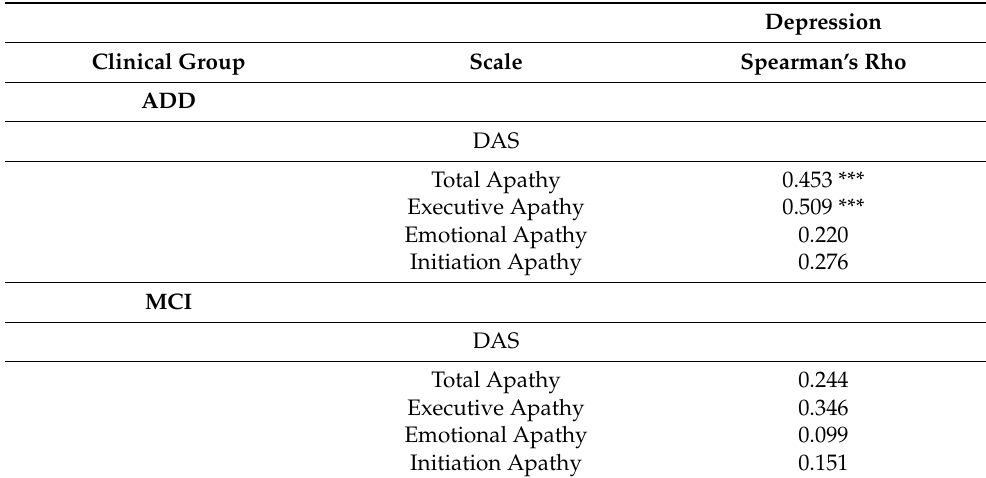
Table 7. Correlations between DAS apathy and DASS depression among the different clinical groups.